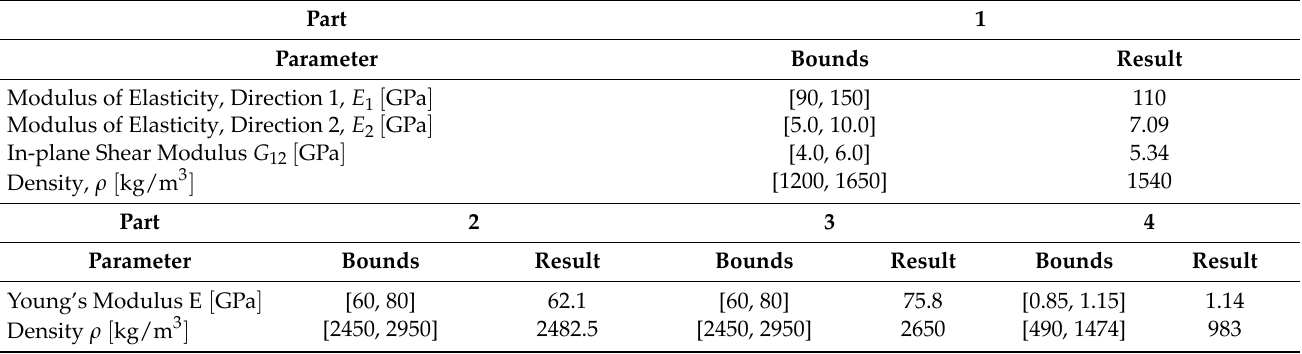
Table 2. Updated FE model material